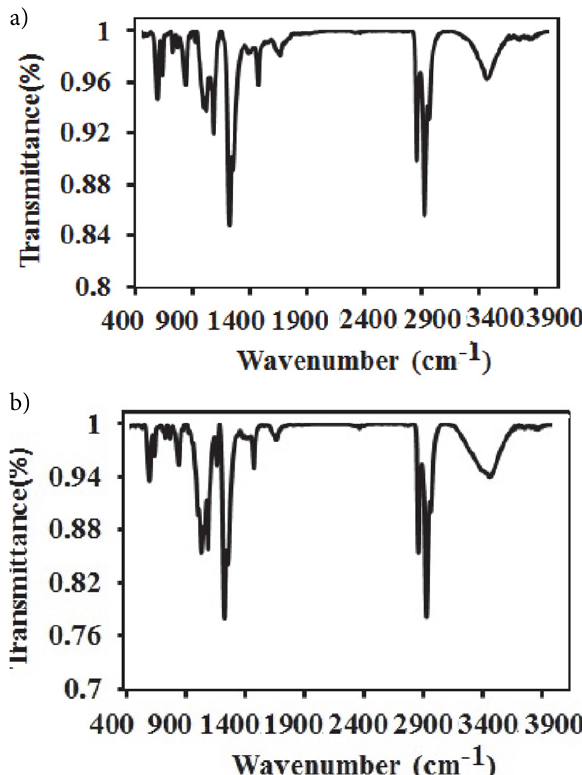
Figure 2. TEM images of the synthesized AgNPs: (a) SDS-AgNPs and (b) SDS-CD-AgNPs.